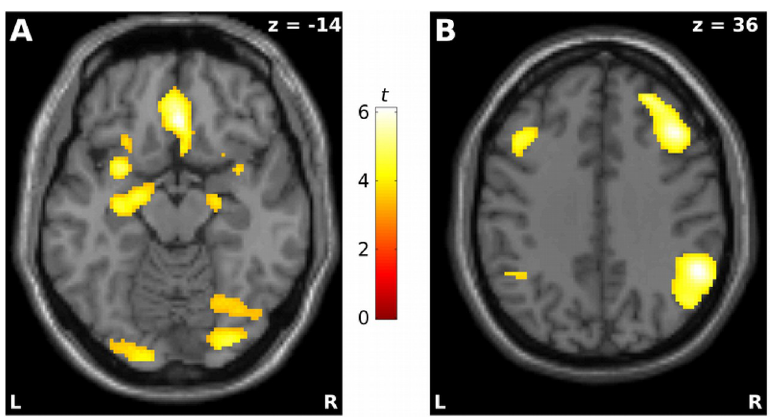
Fig 1. Whole-brain analysis of concurrent main effects of regulation (stimulation phase, timepoint 1). A. Permit > Distance during the stimulation phase. B. Distance > Permit during the stimulation